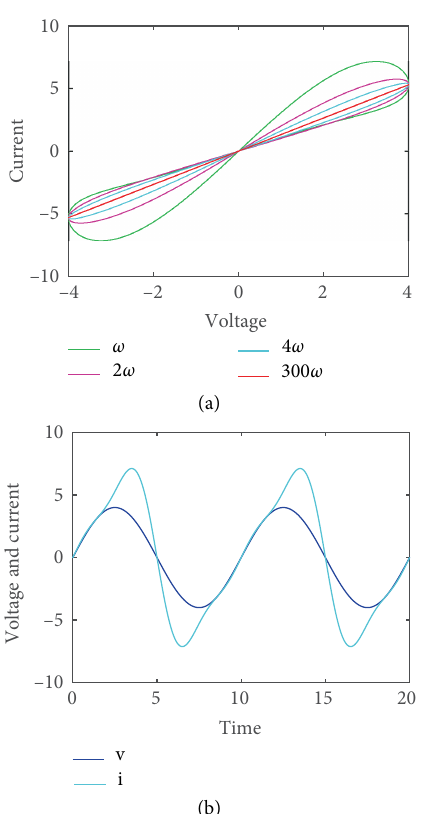
memristor.Figure